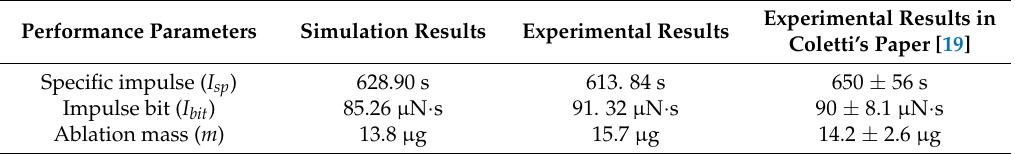
Table 4. Comparison of performance parameters between experiment and simulation.